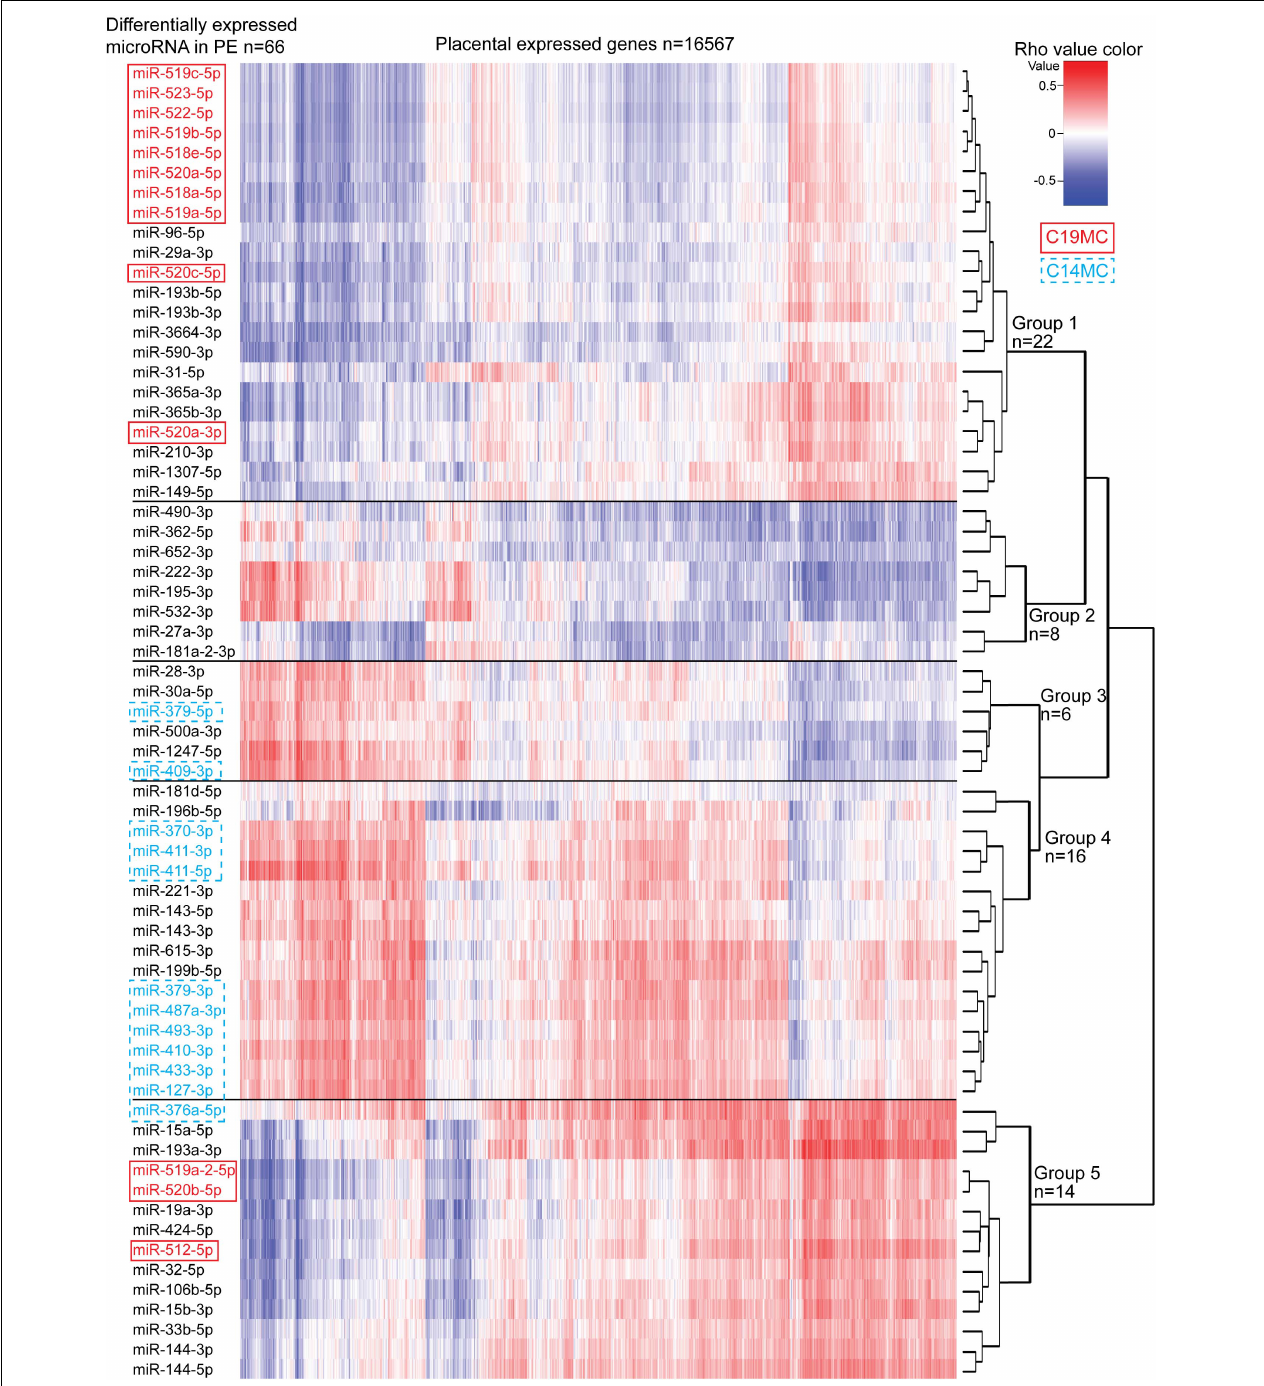
FIGURE 5 | Correlation analysis between miRNAs altered in preeclampsia and the whole transcriptome of 40 term placental samples. Expressional correlation of 66 miRNAs with mRNA transcripts of 16,567 genes (RNA-Seq data from Sõber et al., 2015) was evaluated using Spearman’s correlation coefficient (parameter rho). Spearman’s rho was estimated for 1,093,422 miRNA-gene pairs ( Supplementary Data 1 ). The heatmap shows the hierarchical clustering of miRNAs based on the expressional correlation with mRNA transcripts of coding/lincRNA genes. Each row represents one miRNA and each column one gene. Expressional correlation is presented from –1 (maximum negative correlation, blue color) to 1 (maximum positive correlation, red). The value 0 indicates no correlation. miRNAs groups G1-G5 were formed based on their clustering. More details on genes with correlated expression in each miRNA group G1–G5 are presented in Supplementary Tables 28–32